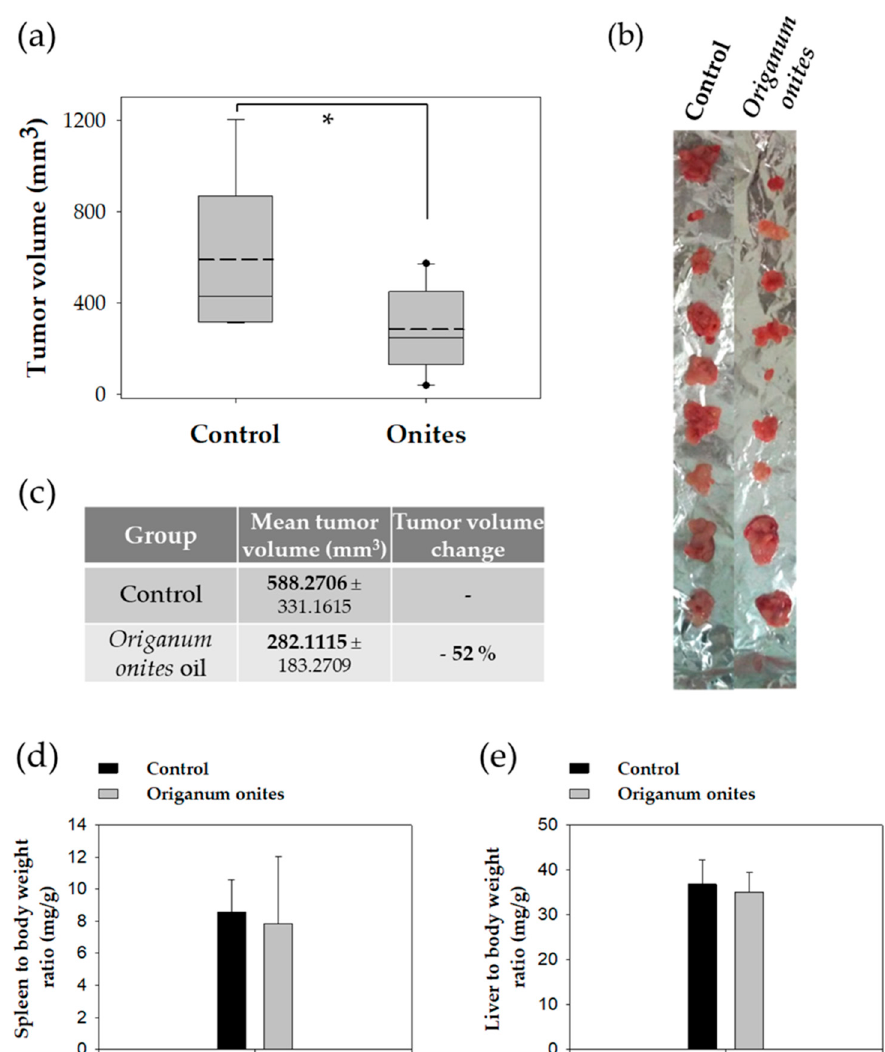
Figure 5. Oral administration of OOEO inhibits the growth of colon carcinoma in mice. OOEO was administered orally daily to BALB/c mice for 13 days (0.370 g/kg body weight/day). On the 10th day, mice were inoculated subcutaneously with CT26 cancer cells, and seven days later, tumors were harvested from euthanized animals ( n = 10 per group). A statistically significant reduction of ≈ 52% in tumor volume ( p = 0.022, Student’s t-test) was observed in the group that was receiving the oil as compared to the control mice. ( a ) Graphical representation of tumor volume distribution (solid lines indicate median and dashed lines indicate mean values), ( b ) photographic observation, and ( c ) mean tumor volume of excised tumors. No significant di ff erences were observed between ( d ) spleen or ( e ) liver weight to body weight ratios between control and oil-treated mice. Asterisk indicates a statistically significant di ff